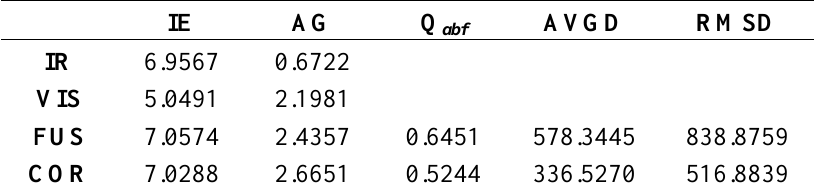
Table 5. Quantitative analysis of IR and VIS image fusion and correction (1300 LST 25 July 2006).